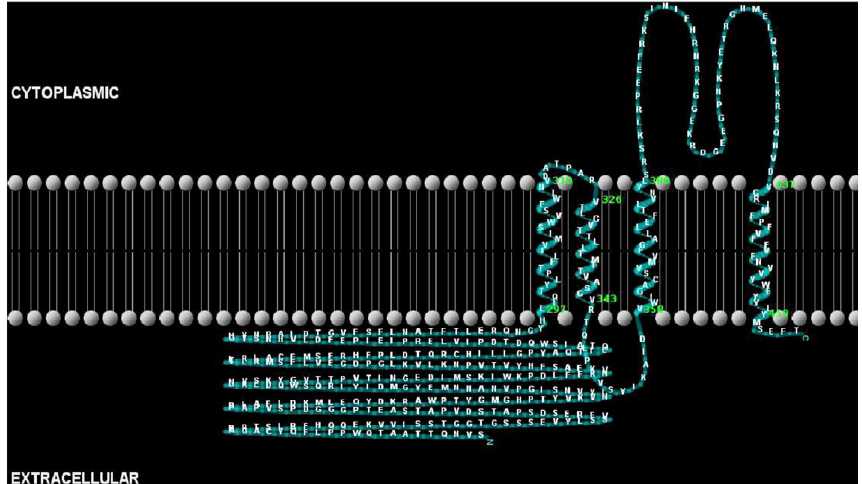
Figure 2. Two-dimensional representation of the putative GlyR channel from R. microplus showing the extracellular, transmembrane and intracellular